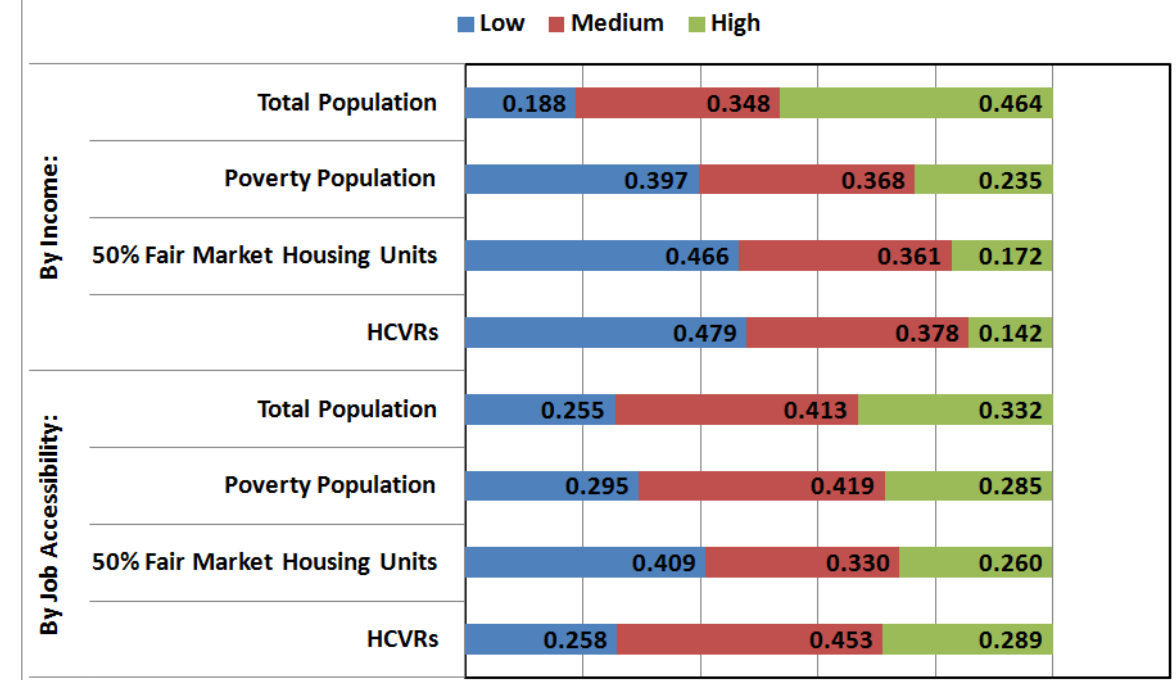
Figure 1. Distribution of total population, poor, HCVRs and FMR by select suburban characteristics, 2008. Source: author’s analysis of HUD data, Census 2000 and ACS five-year estimates 2005−2009, an early version